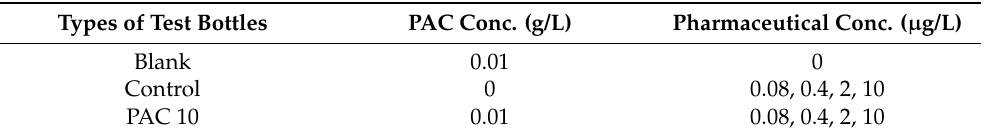
Table 1. Experimental setup, including pharmaceutical concentrations and PAC